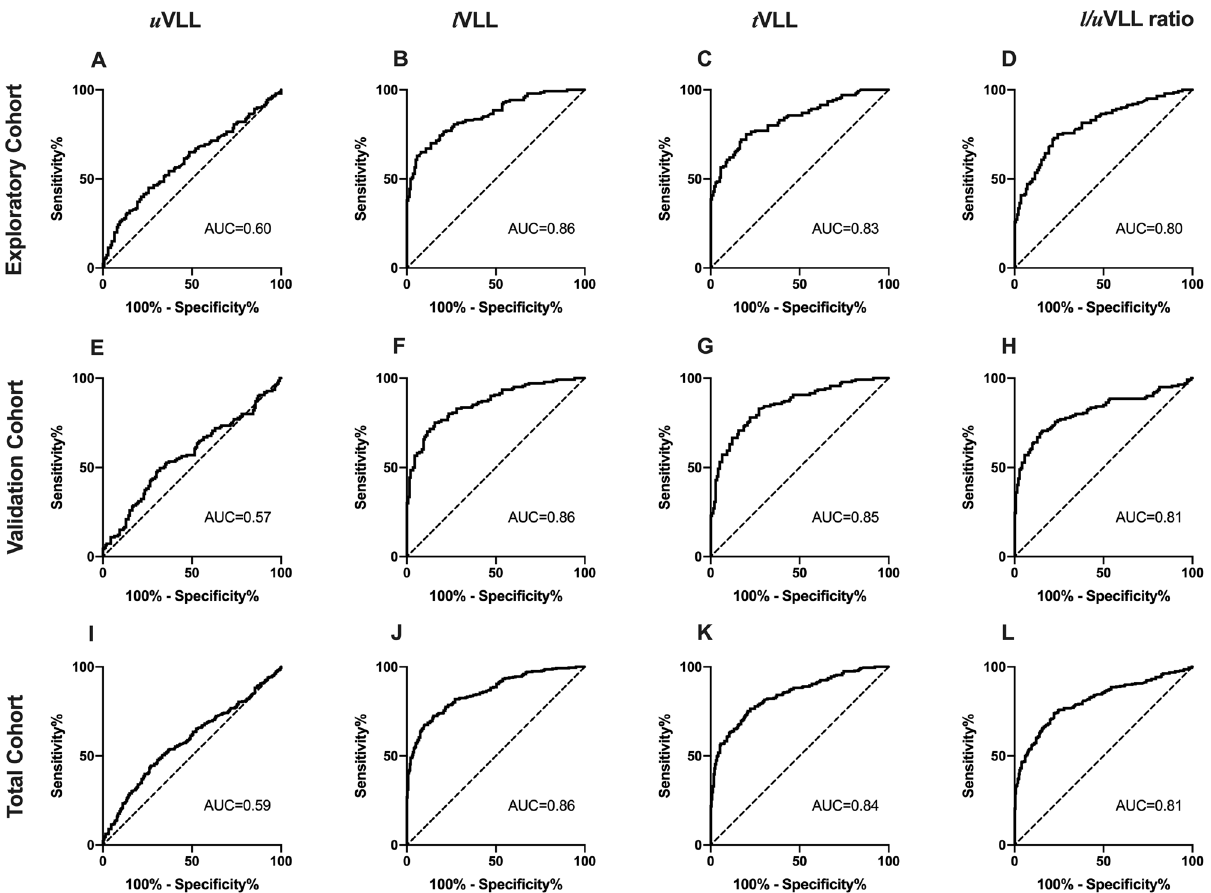
Figure 4. Receiver operating characteristic curves of vertical lung lengths (VLLs) for the detection of IIPs. Receiver operating characteristic curve analyses of VLLs in the exploratory ( A – D ), validation ( E – H ), and total cohorts ( I – L ). AUC area under the